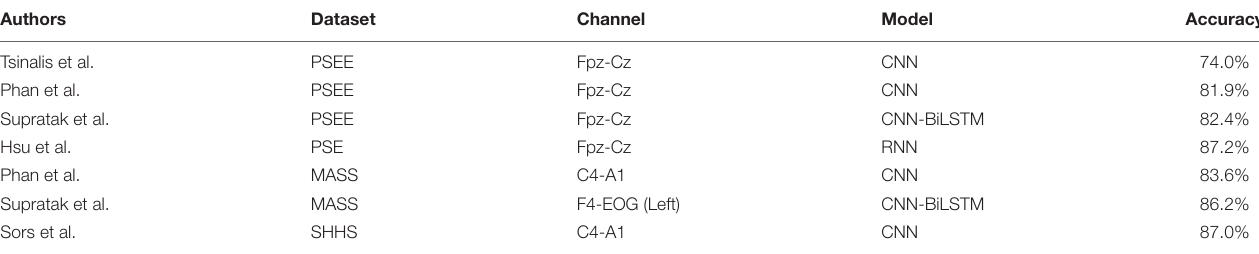
TABLE 1 | An overview of the application of deep networks on sleep staging. Authors Dataset